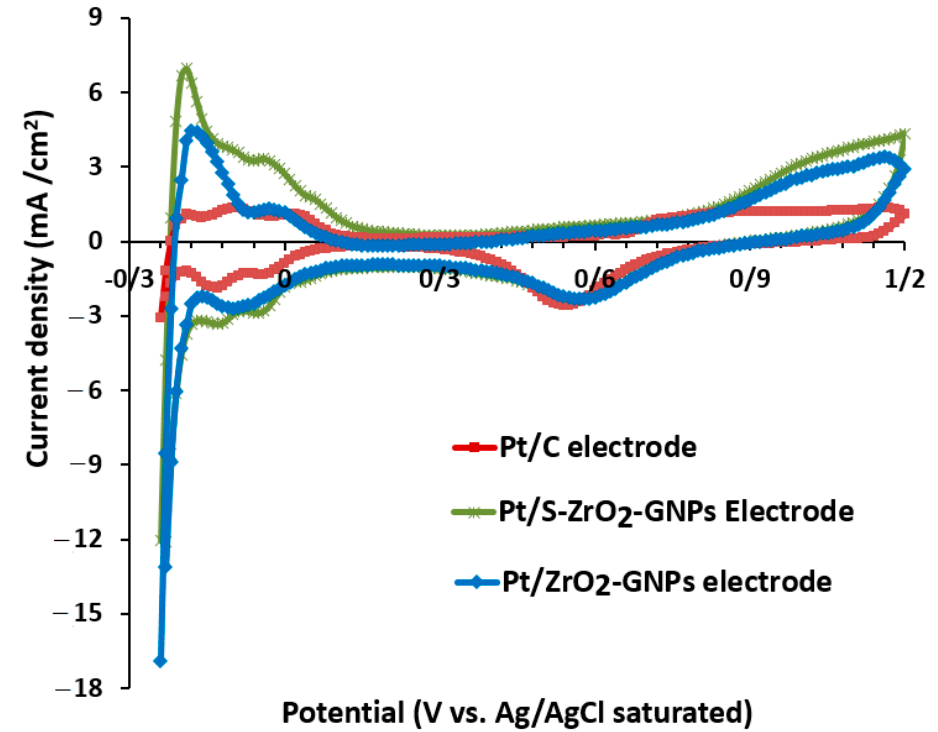
Figure 7. CVs of Pt/S-ZrO 2 -GNPs, Pt/ZrO 2 -GNPs, and Pt/C in 0.5 M H 2 SO 4 solution scan rate: 50 mV s − 1 at 25 ◦ C under N 2 flux.